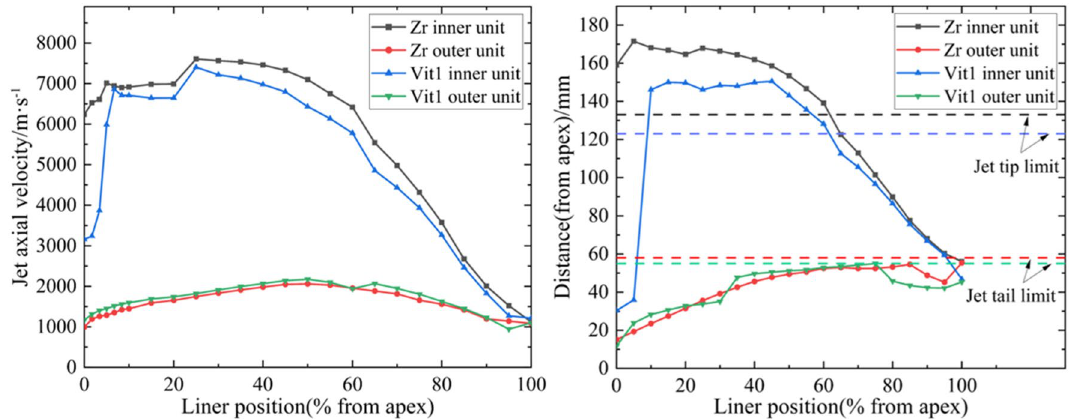
Figure 13. Particle motion characteristics (30 μs).